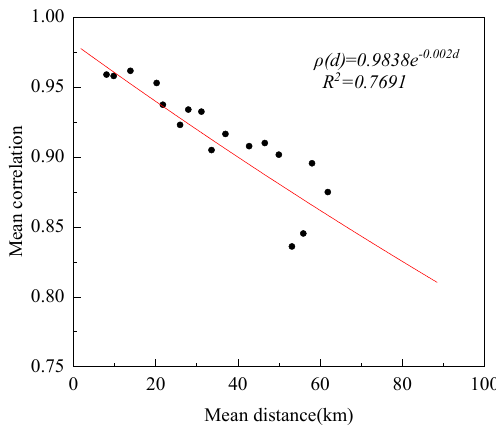
Figure 5. Scatter plots of the MC and MD between rain gauges.